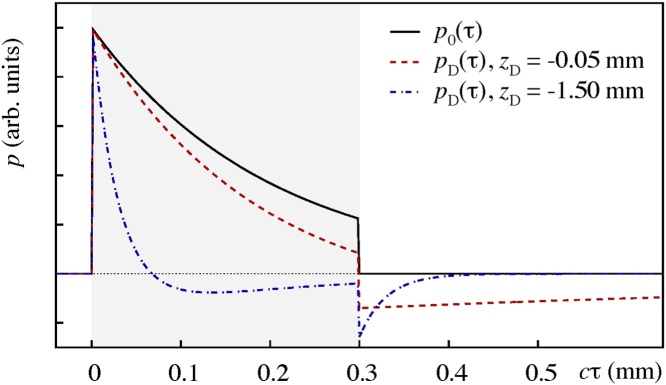
Illustration of OA signals obtained in the acoustic near-field (D = 0.22; red dashed curve) and far-field (D = 6.67; blue dash-dotted curve). The signals are obtained by solving the Volterra integral equation of the second kind, Eq. (4), that mediates the shape transformation of the initial acoustic stress profile (black solid curve) in the paraxial approximation. For the preparation of the initial stress profile it is assumed that μa = 5 mm−1 in the range [cτ−, cτ+] = [0, 0.3] mm and zero elsewhere. The convolution kernel reflects a Gaussian irradiation source profile with 1/e-width aB = 0.3 mm.